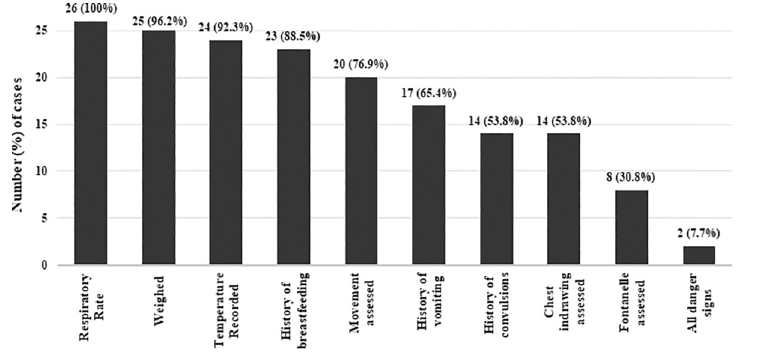
Fig 1. Assessment of sick young infants by health care providers for PSBI danger signs (n = 26).